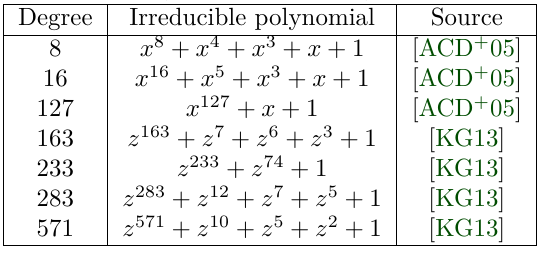
Table 1: List of irreducible polynomials for binary finite fields used in this